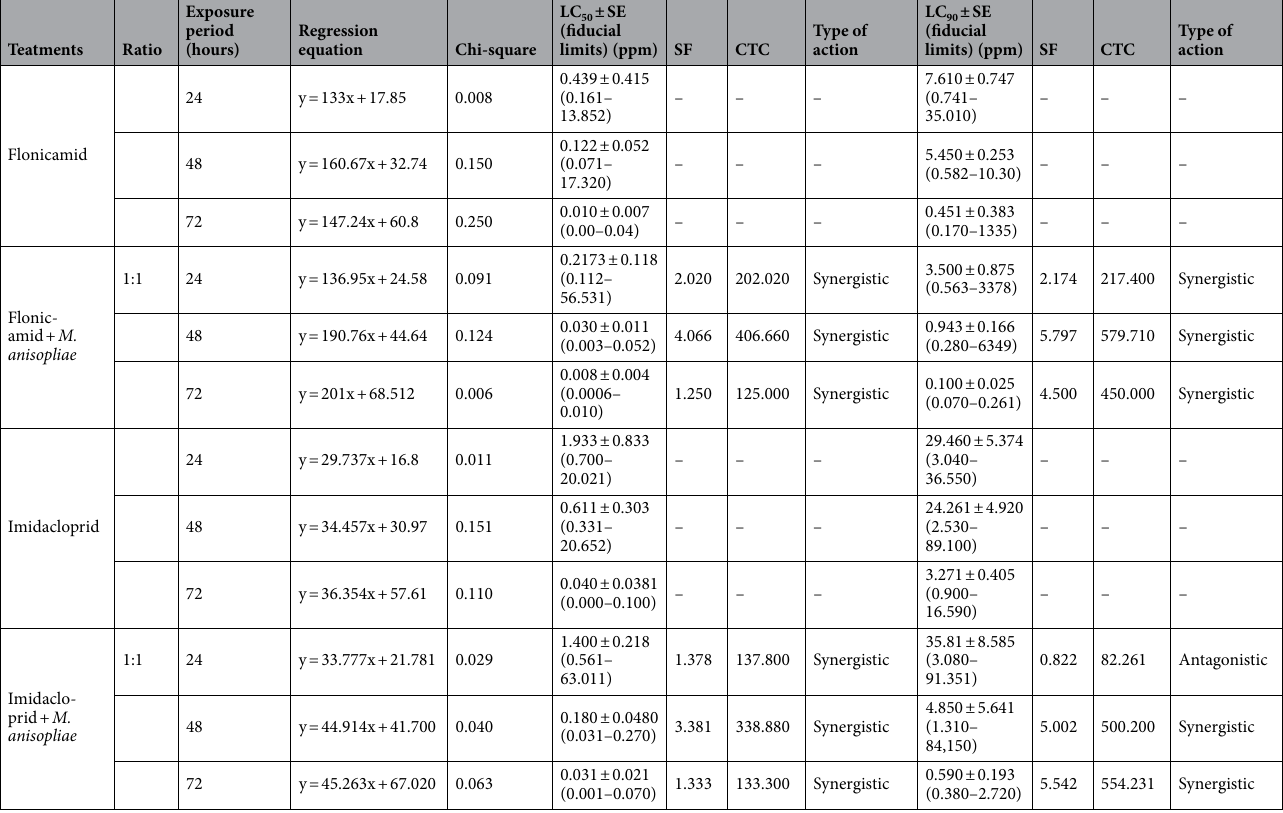
Table 2. Toxicity of insecticides (Flonicamid and Imidacloprid) with and without M. anisopliae for A. gossypii. CTC co-toxicity coefficient, SF synergy